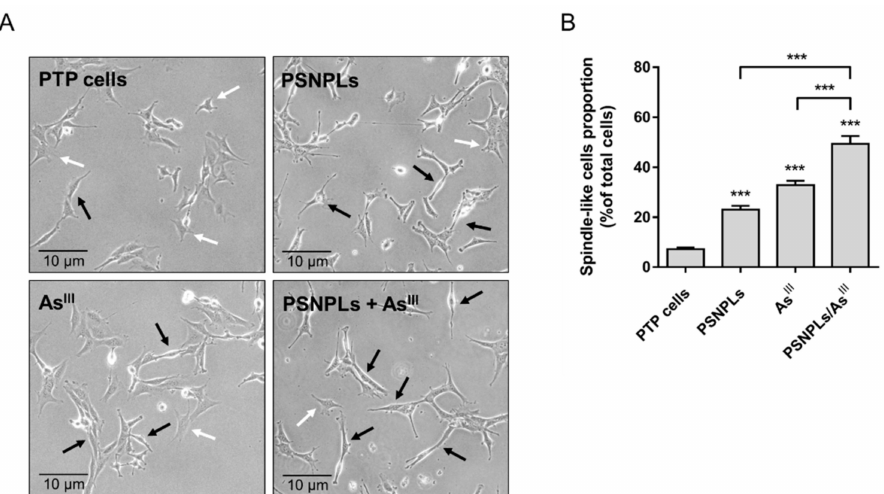
Figure 5. Chronically (co)exposed PTP cells morphology evaluation. ( A ) Representative images of non-exposed PTP, and PTP cells after the chronic exposure to 25 µ g/mL PSNPLs, 2 µ M As III , and the combination of both PSNPLs/As III . Arrows point to cells with flattened stellate shape (white) or to spindle-like cells (black). ( B ) The proportion of spindle-like cells was quantified in five different fields for each tested condition. Data are presented as mean ± SEM analyzed by one-way ANOVA with Dunnett’s post-test (*** p < 0.001, compared to passage-matched PTP cells or other conditions as